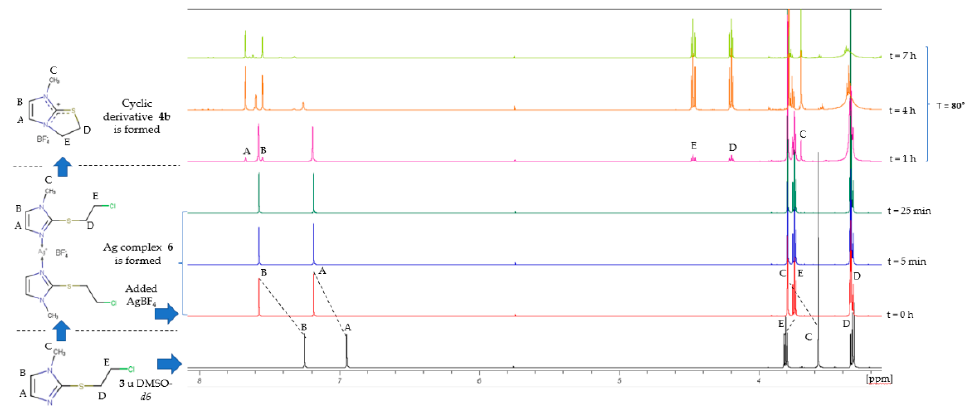
Figure 6. Conversion of 3 to 6 and 4b monitored by NMR spectroscopy in DMSO- d 6 .